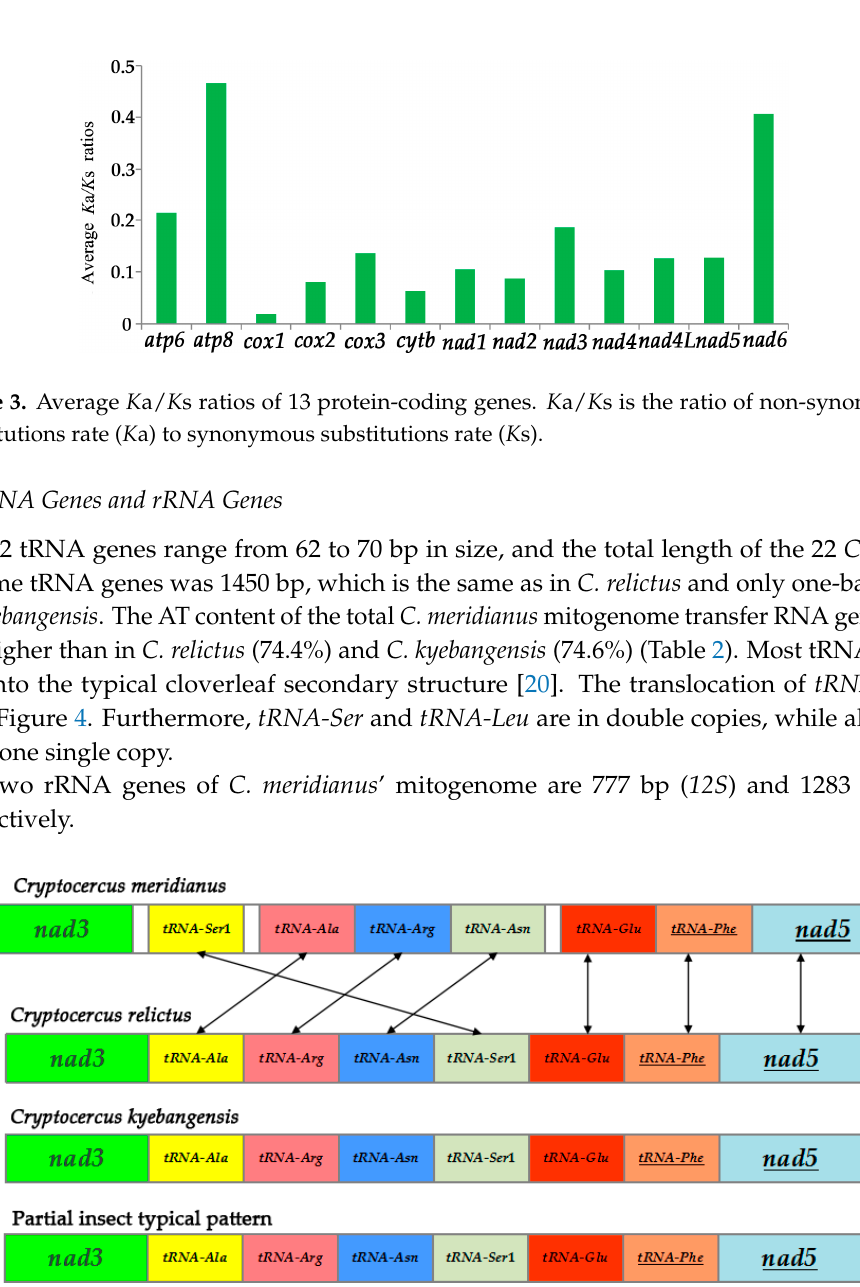
Figure 2. Relative synonymous codon usage (RSCU) for protein coding genes of the three Cryptocercus mitochondrial genomes. Codon families are provided on the x -axis.